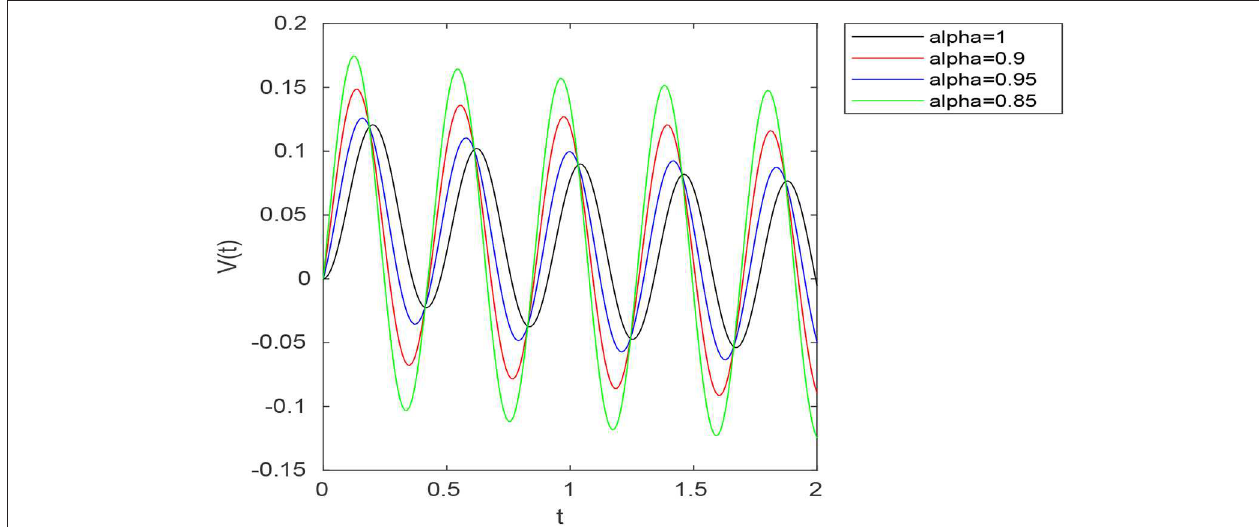
FIGURE 4 | Graph of the voltage in the RC circuit for different values of α with µ ( t )